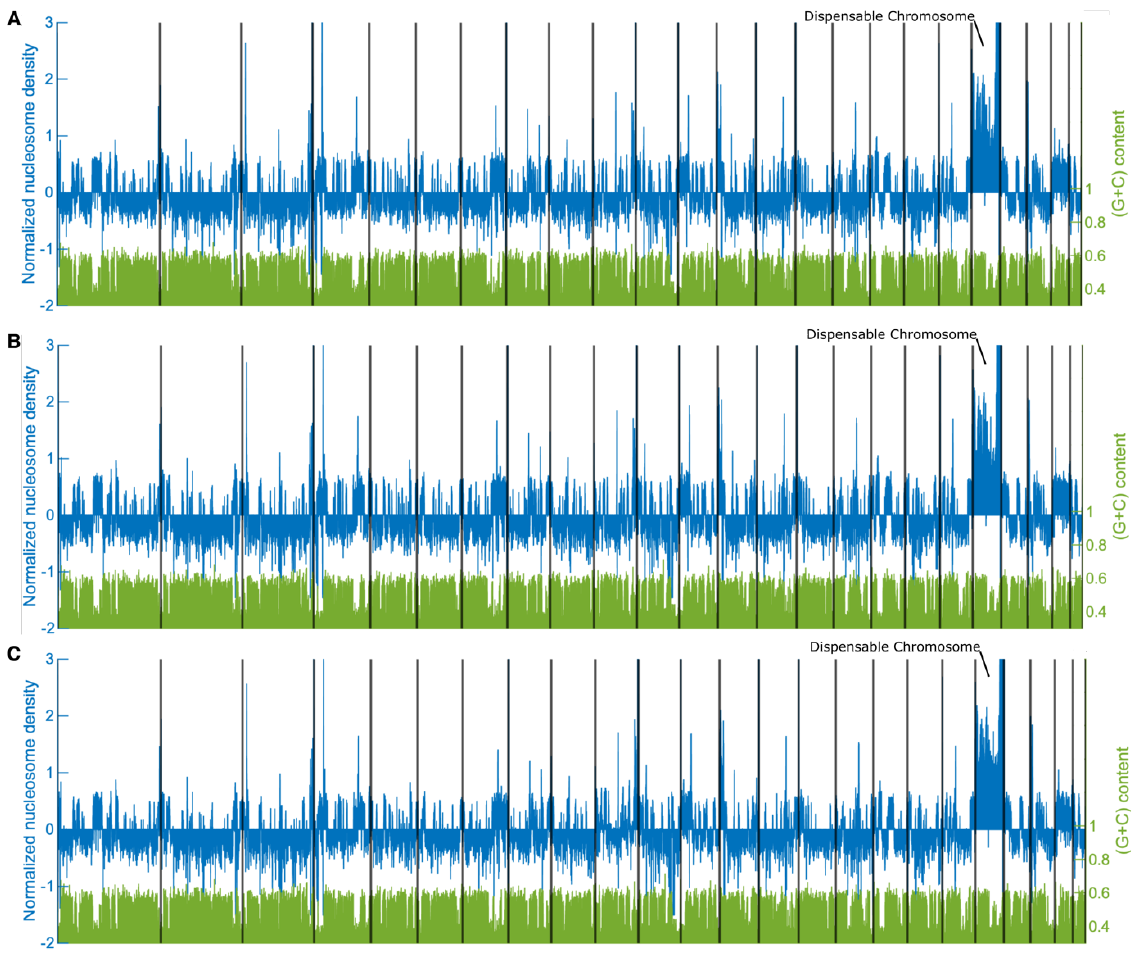
Supplementary Figure 5. Normalized nucleosome density profiles vs . AT content in individual biological replicates of Leptosphaeria maculans ‘brassicae’. Z-scored coverage density profiles were computed for non-overlapping 1 kb-long bins along all supercontigs, separated by black lines. AT-rich 1 kb-long bins are plotted in green, isochores showing as dense regions (Rouxel et al. , 2011). In blue are plotted the z-scored average nucleosome density profile ( A) . Biological replicate #1; ( B) . Biological Replicate #2; ( C) . Biological replicate